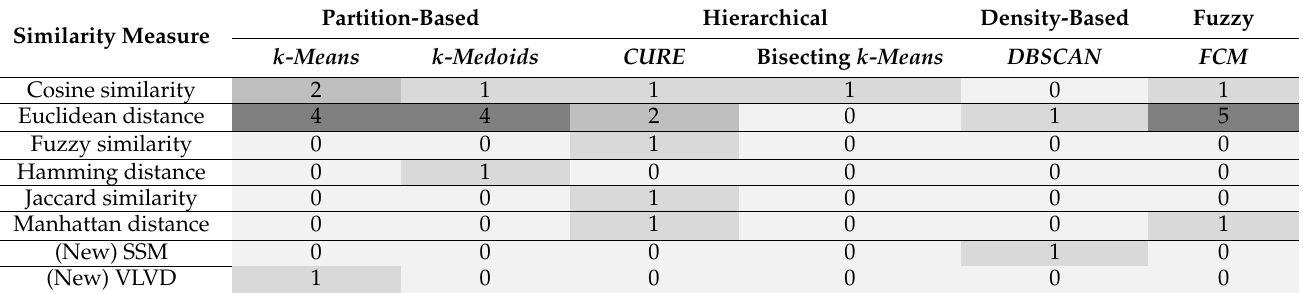
Table 2. Frequency heat map of similarity measure with respect to the clustering